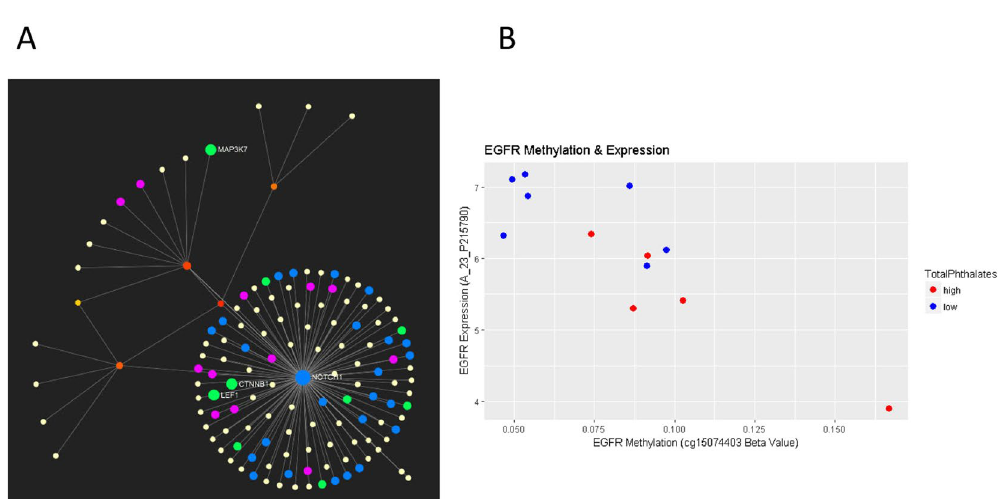
Figure 3. ( A ) Network evaluation resulting from pathway analysis of methylation-gene expression analysis. ( B ) Correlation between methylation and expression for EGFR. The EGFR expression by EGFR methylation levels are plotted. The methylation is represented as Beta-value from the cg15074403 probe while the expression value is represented by probeset A_23_P215790. The Pearson correlation between this expression probeset and the cg15074403 M-value is − 0.83 (p-value = 0.00076). Subjects with high phthalate exposure are shown in red, while those with low exposure are shown in